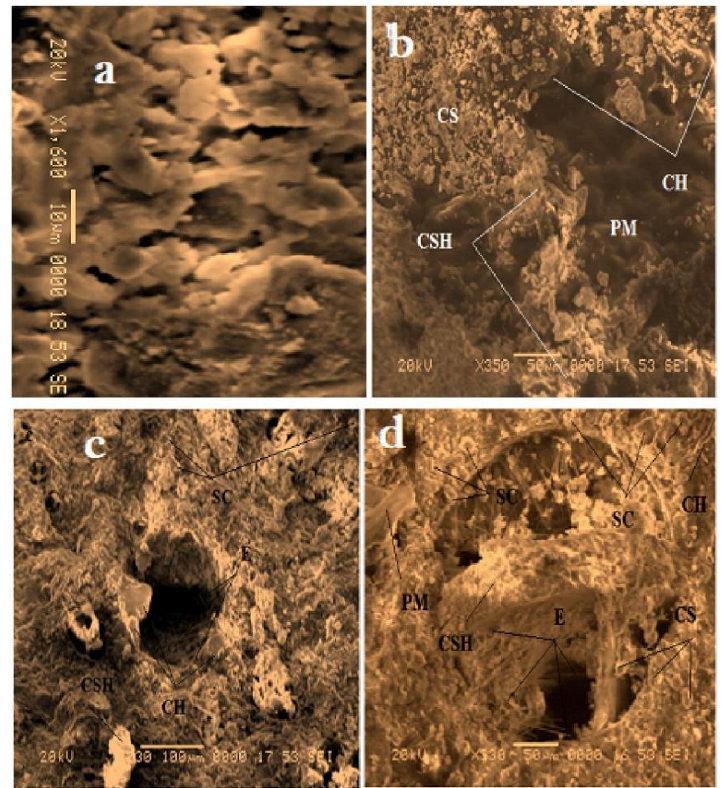
Figure 26. Microstructure of the composite material under various conditions ( a ) before immersion and after immersion in ( b ) plain water, ( c ) groundwater, and ( d ) seawater for 420 days. Portlandite [CH], calcium silicate hydrate [CSH], salt crystals [SC], ettringite [E], and polymer matrix [PM]. Reprinted with permission from ref. [67].